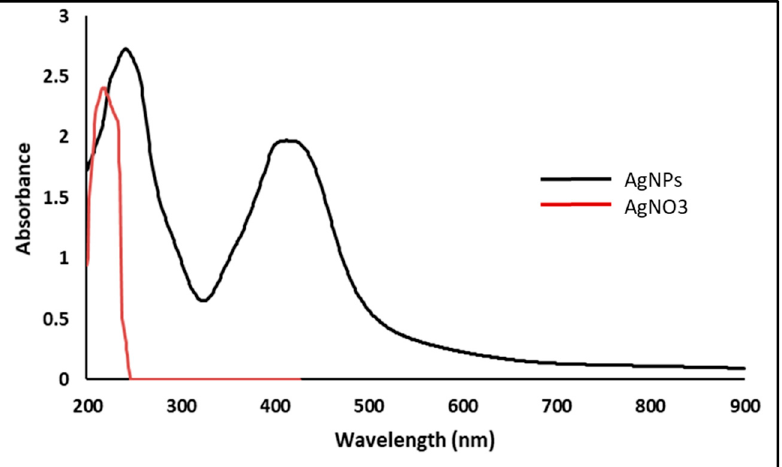
Figure 2. UV spectrum of AgNPs.